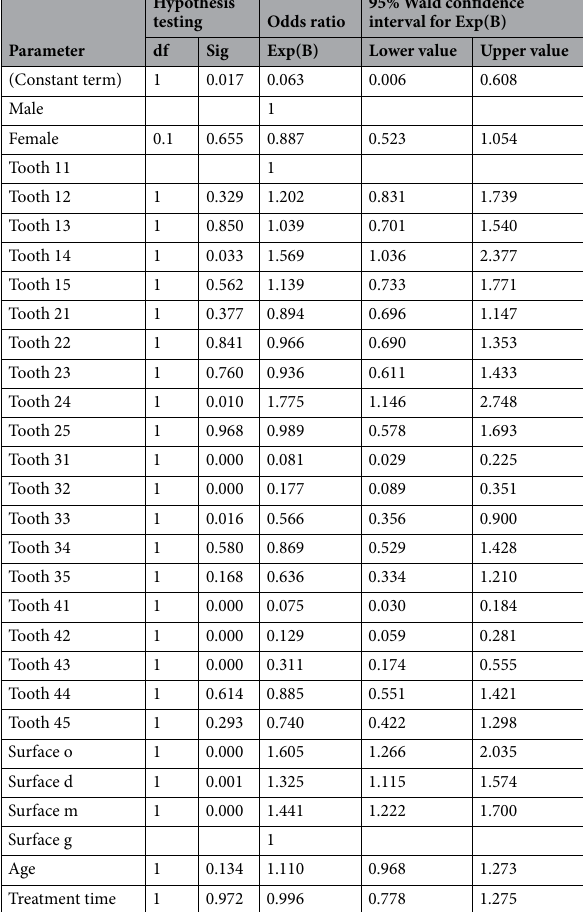
Table 3. Overview of the parameters for the logistic regression: WSL prior to MB